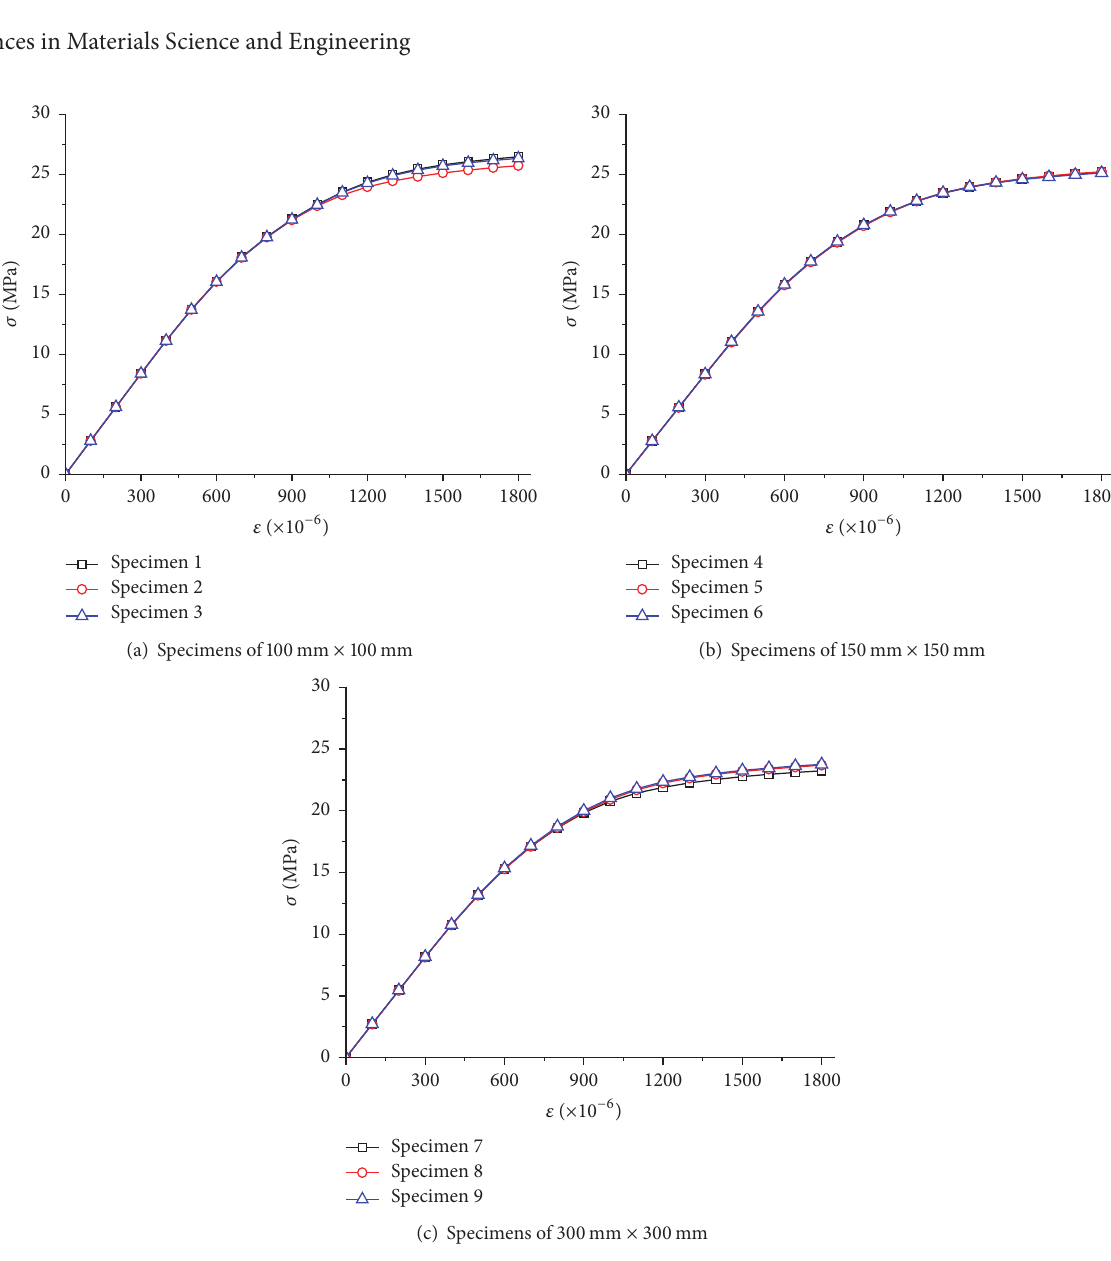
Figure 7: Uniaxial compressive stress-strain curve of RAC